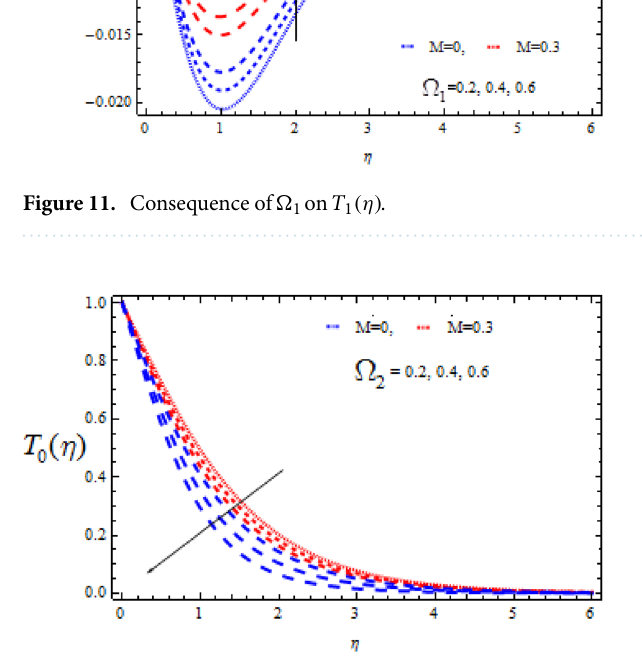
Figure 12. Consequence of (cid:31) 2 on T 0 (η) .